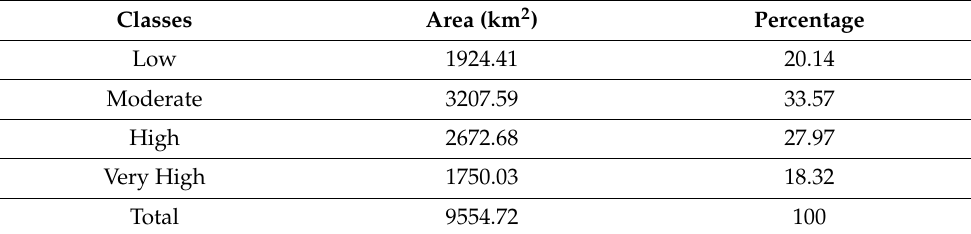
Table 4. Susceptibility area.